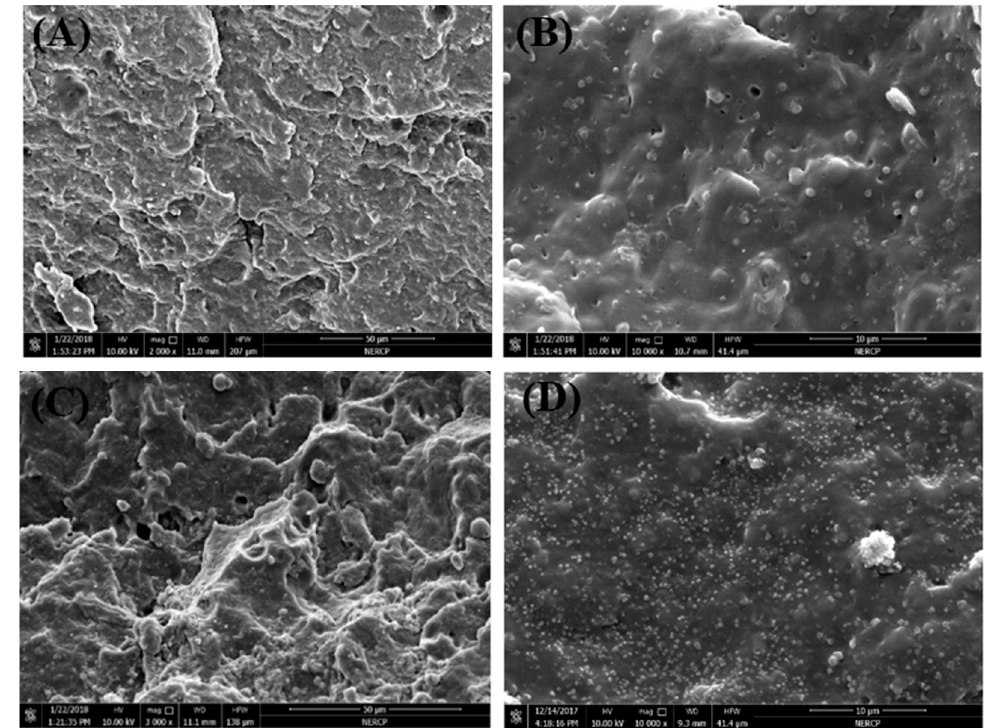
Figure 11. SEM photos of microstructure of EPDM/PP/IFR composites: ( A , B ) compound MP/PER; ( C , D ) reactive MP/PER.